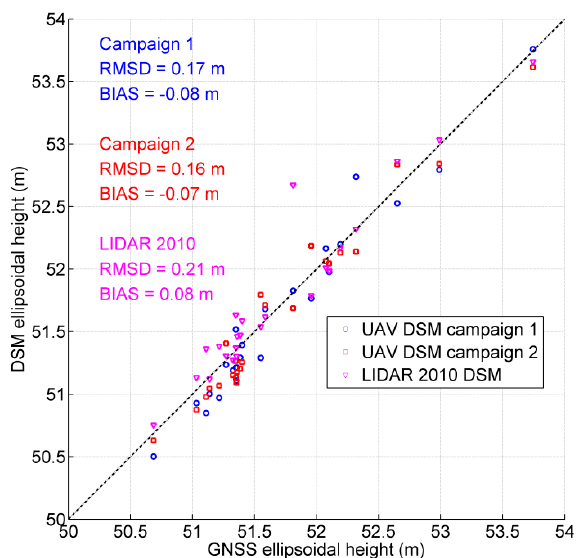
Figure 10. Scatter plot of ICPs’ ellipsoidal heights between DSMs data and GNSS data. The blue dots correspond to campaign 1 while the red dots correspond to campaign 2.